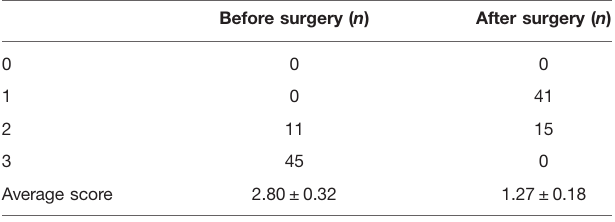
TABLE 2 | Comparison of preoperative and postoperative carunculae lacrimalis exposure score ( n =56 cases).